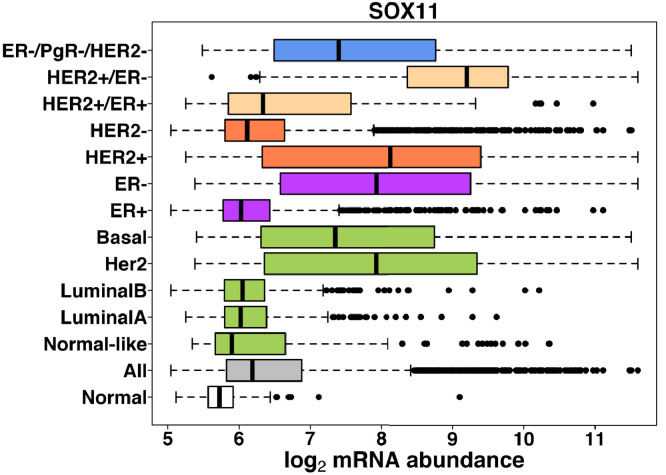
SOX11 levels in breast cancer METABRIC dataset.